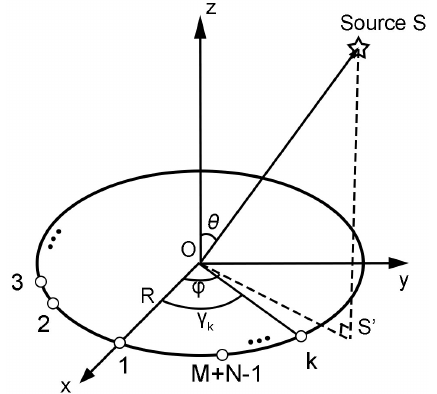
Figure 2. CPCA signal model.